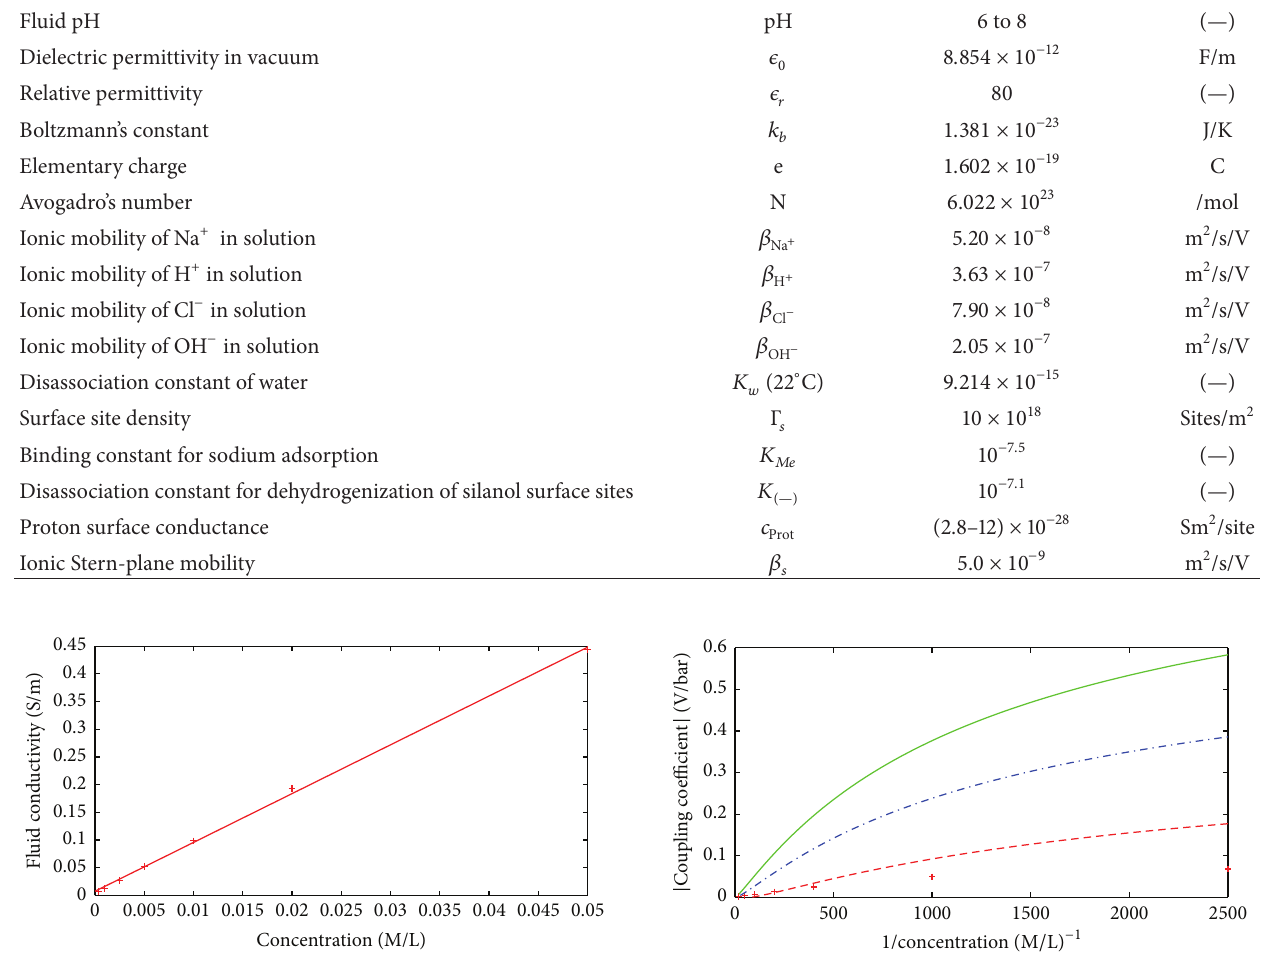
Figure 2: Fluid conductivity versus electrolyte concentration for sample IND01.